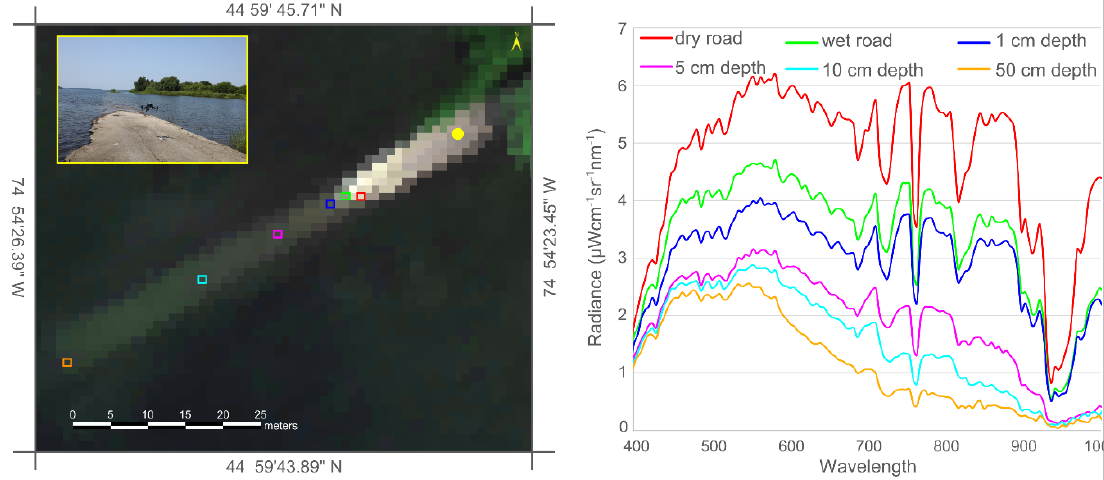
Figure 4. The attenuative effect of the water column on the recorded signals of a flooded cement road at the Long Sault Parkway, ON, from airborne hyperspectral imagery (HSI) (CASI-1500). The colored boxes identify the pixels for which the spectra are shown on the right in units of radiance. The pixels chosen represent an increasing effect of the water column, with the dry road pixel being entirely unaffected by water. The inset photo shows what the flooded road looks like from the ground and was taken at the point indicated by the yellow circle. Note that the spectra here are in radiance, prior to atmospheric correction, as such the strong atmospheric water absorption features (e.g., 940 nm) can be seen in the spectrum from the dry road.